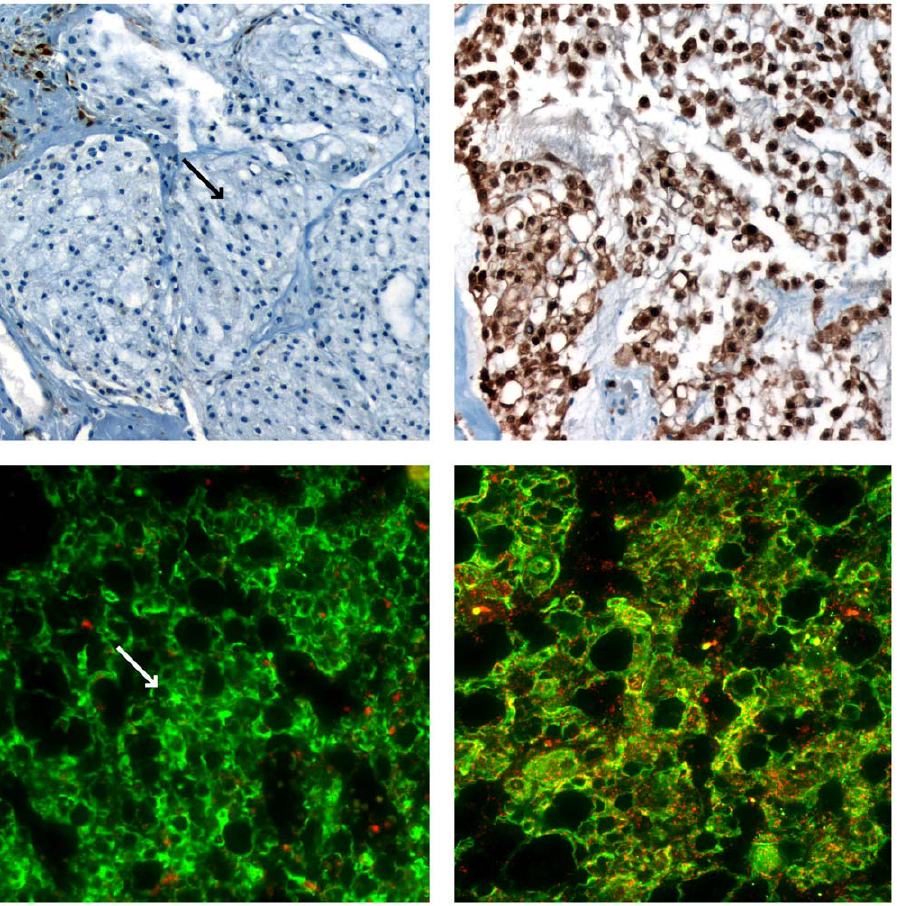
Figure 4. Top Panels: CDKN2A immunohistochemistry. Representative chordoma cases showing lack of expression (left, CH39) and strong expression (right, CH35). Bottom Panels: PTEN Immunofluorescence. Representative chordoma cases were immunostained with anti-cytokeratin to highlight tumor cells (green) and anti-PTEN (red). Tumor cells show lack of PTEN expression in the left panel and expression of PTEN in the right panel. Note in both left panels that stromal tissue or normal cells show expression of CDKN2A and PTEN, but tumor areas indicated by arrows show lack of expression.